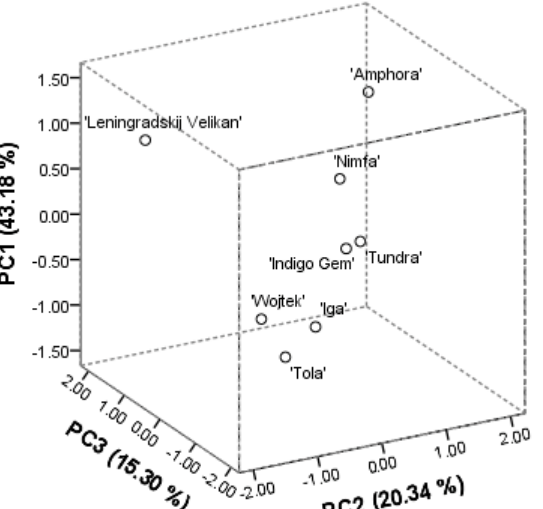
Figure 2. PCA score plots for the three principal components based on the phytochemical composition of L. caerulea fruits.